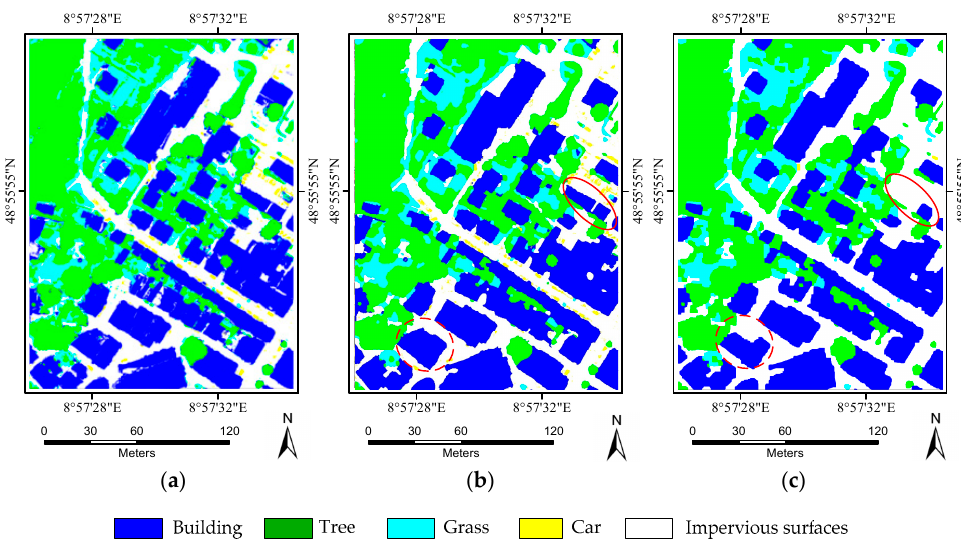
Figure 12. The classification results before and after the CRF refinement. ( a ) Classification map generated by the RFE; ( b ) The refined classification map produced by our long-range FCCRF; ( c ) The refined classification map produced by the classical short-range CRF.